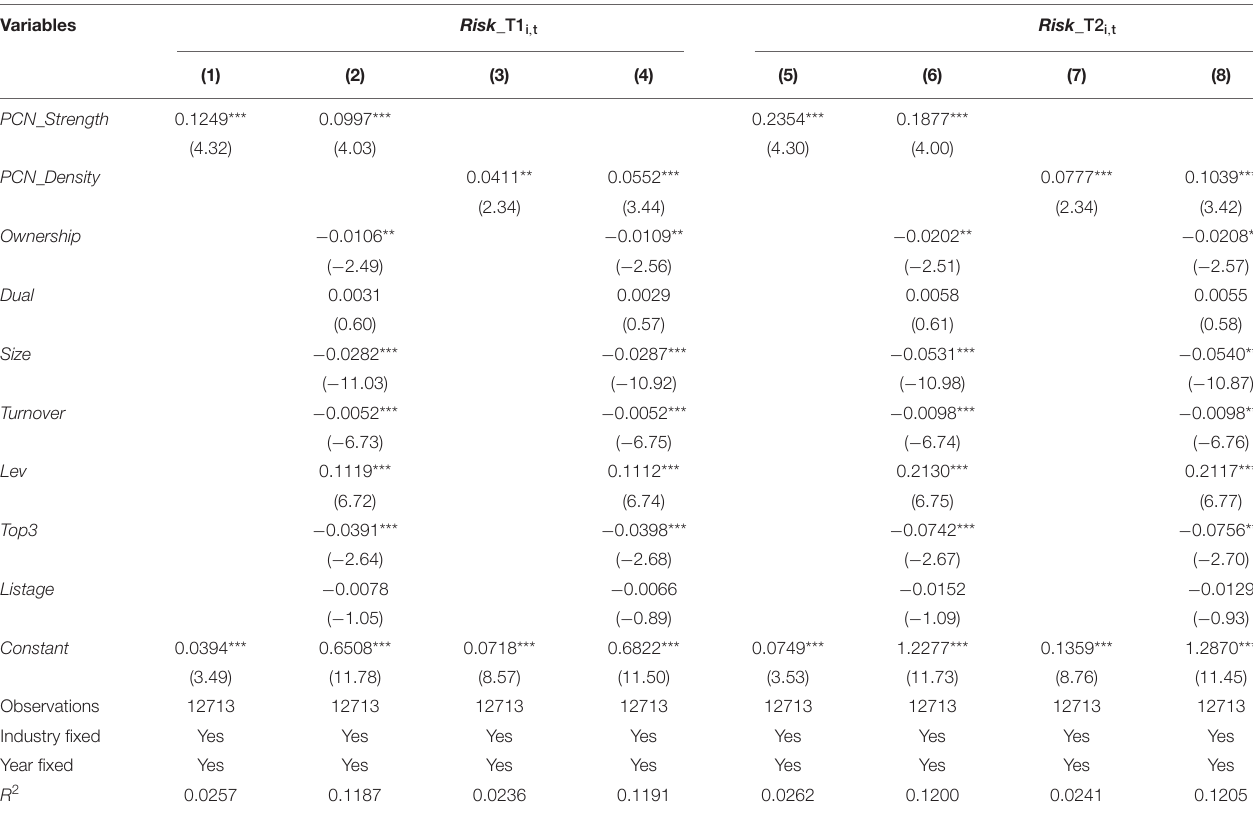
TABLE 4 | The impact of perceived competition networks on corporate risk-taking.